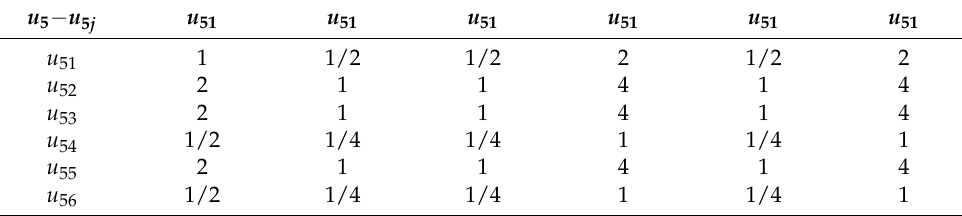
Table 7. Judgment matrix of u 5 − u 5 j